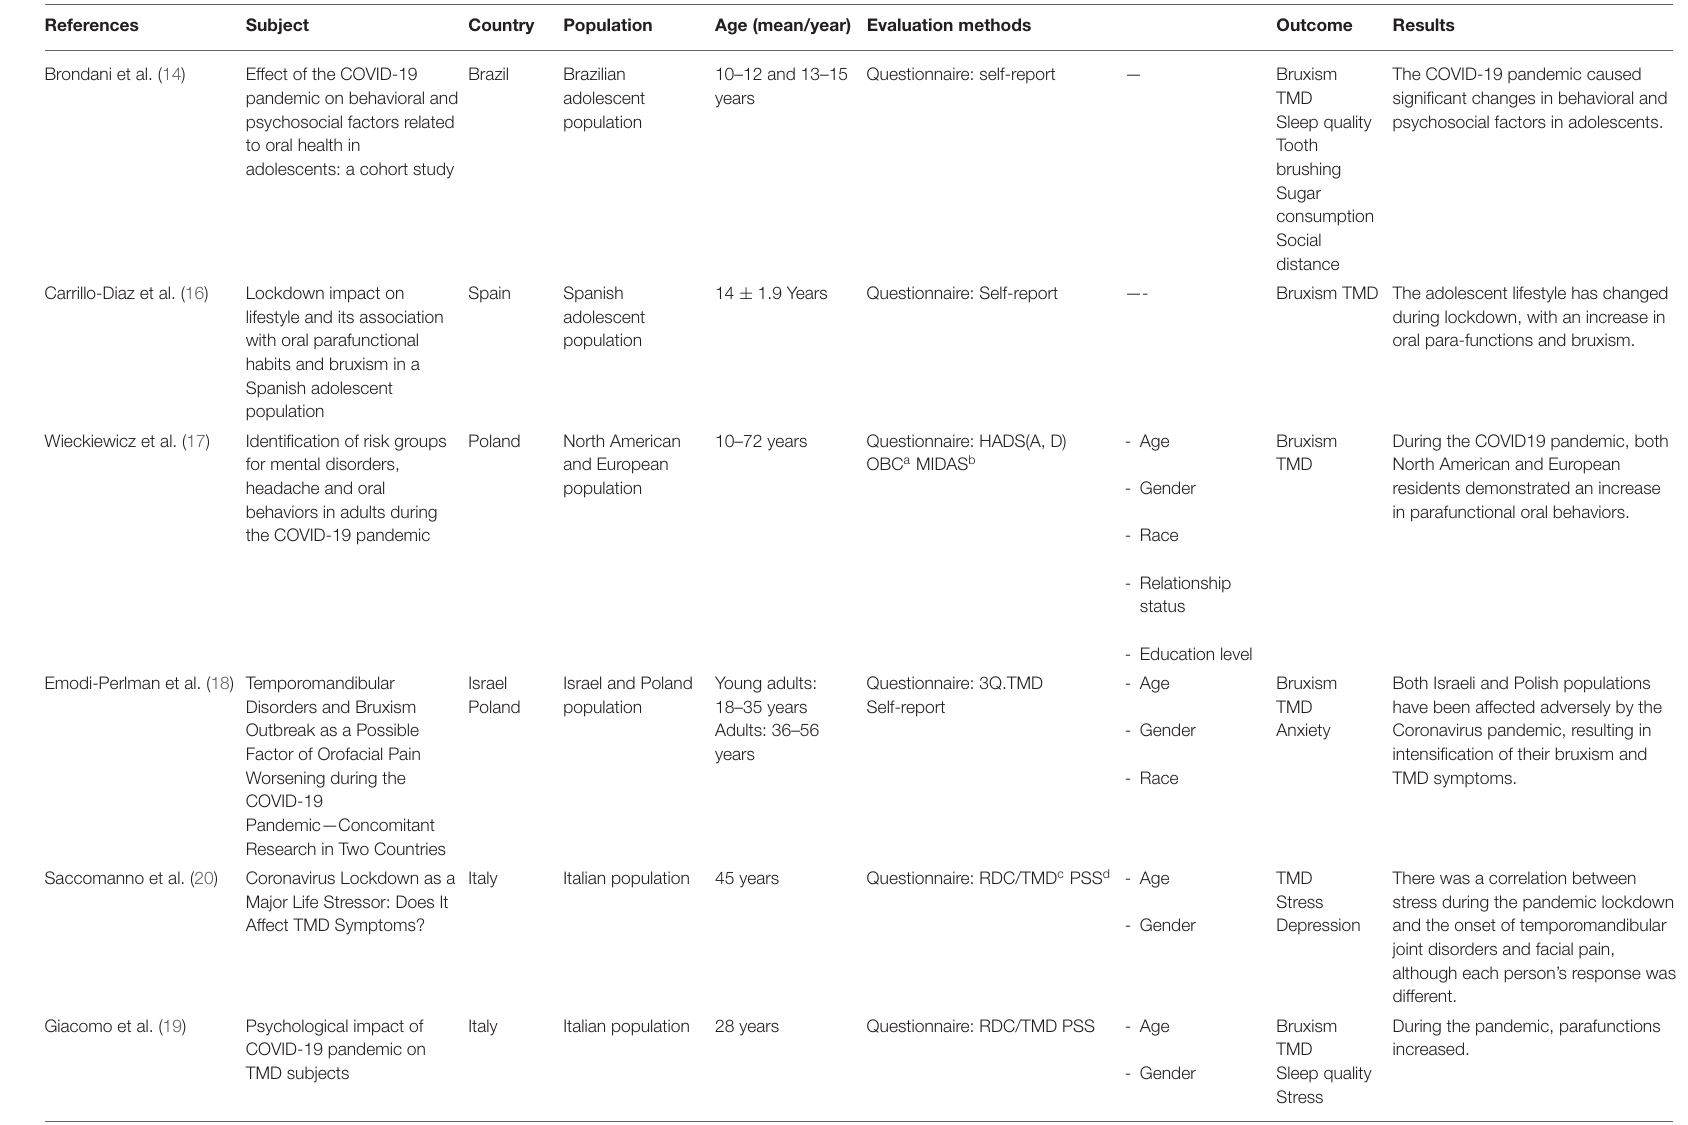
TABLE 4 | Summary of articles.